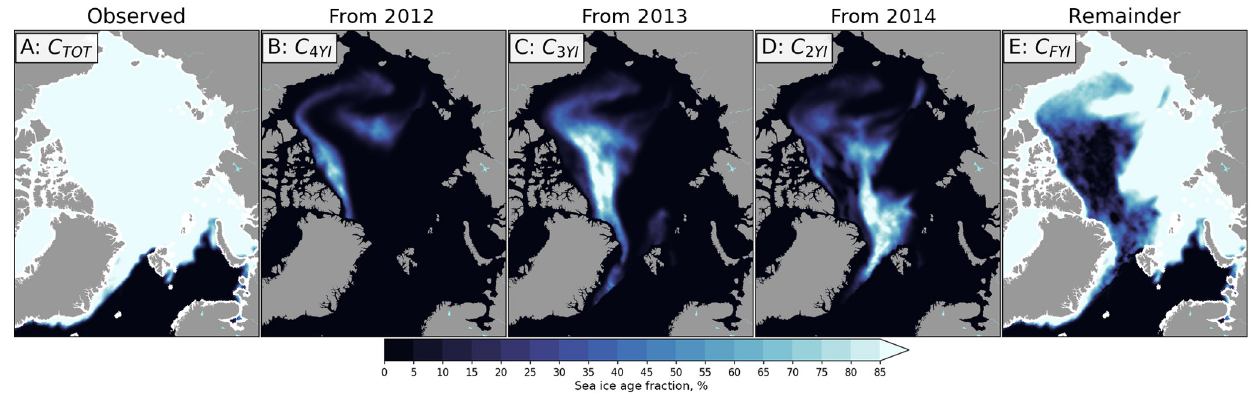
Figure 4. Maps of sea ice age fractions on 1 March 2015. (a) Observed total sea ice concentration; (b–d) fractions of advected multi-year ice; (e) FYI fraction. Color bar represents the sea ice age fraction concentration.